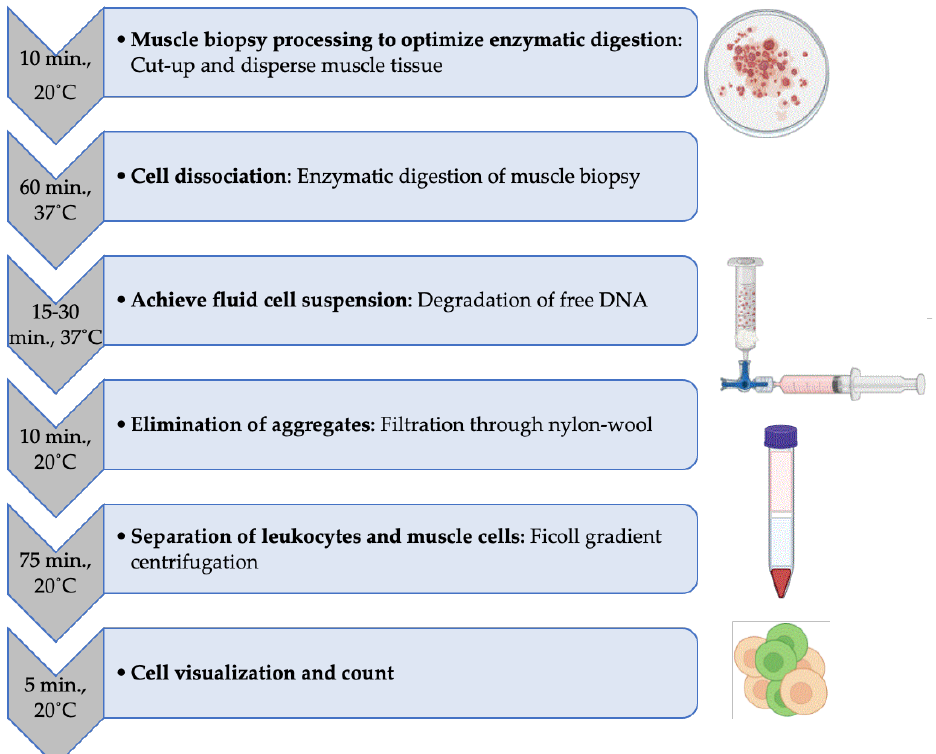
Figure 1. Step-by-step experimental procedure for leukocyte isolation from human muscle biopsy. The average time and temperature condition required for each step are indicated.